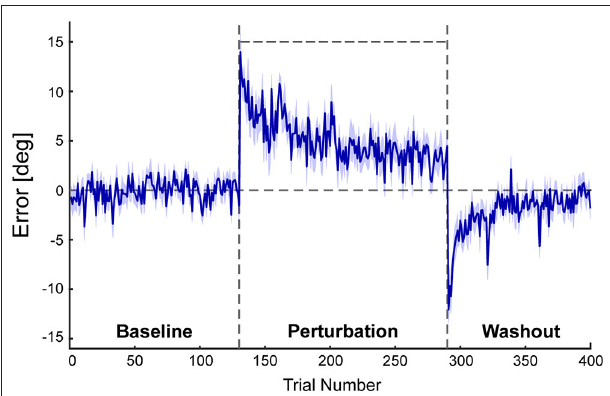
FIGURE 3 | Results of the errors between the center of the target and the endpoint of the virtual ball. This figure shows angular errors between the center of the target and the endpoint of the virtual ball. A positive error corresponds to the deviation of the virtual ball in the direction of the perturbation and vice versa. Blue lines represent the mean errors of all participants. The shaded area represents the standard error of the mean (SEM). Four hundred trials consisted of three phases: the baseline period (130 trials), perturbation period (160 trials), and washout period (110 trials). A horizontal line during the perturbation period (trial 131–290) indicates the perturbation of 15 ◦